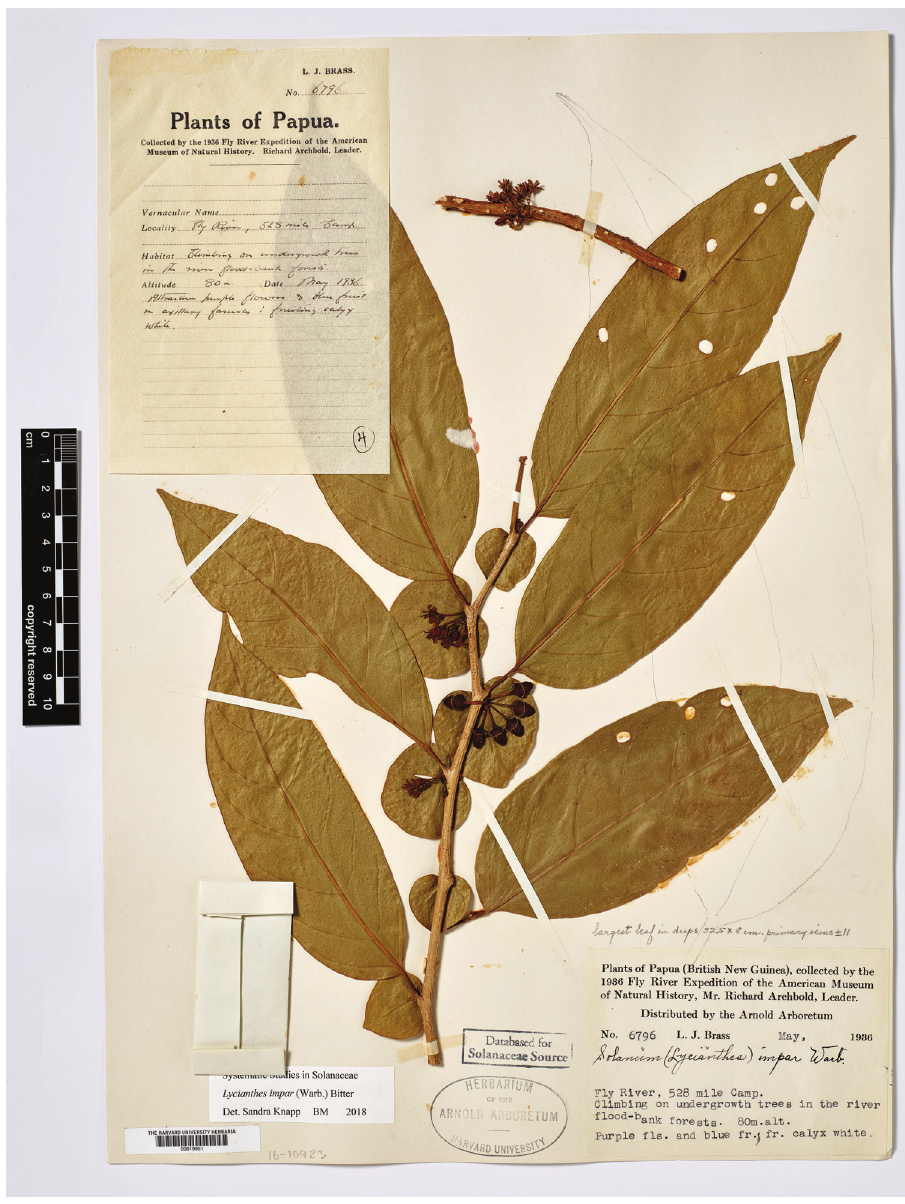
Figure 23. Lycianthes impar herbarium specimen. Indonesia. Papua: Brass 6796 (A). Courtesy of the Herbarium of the Arnold Arboretum of Harvard University, reproduced with